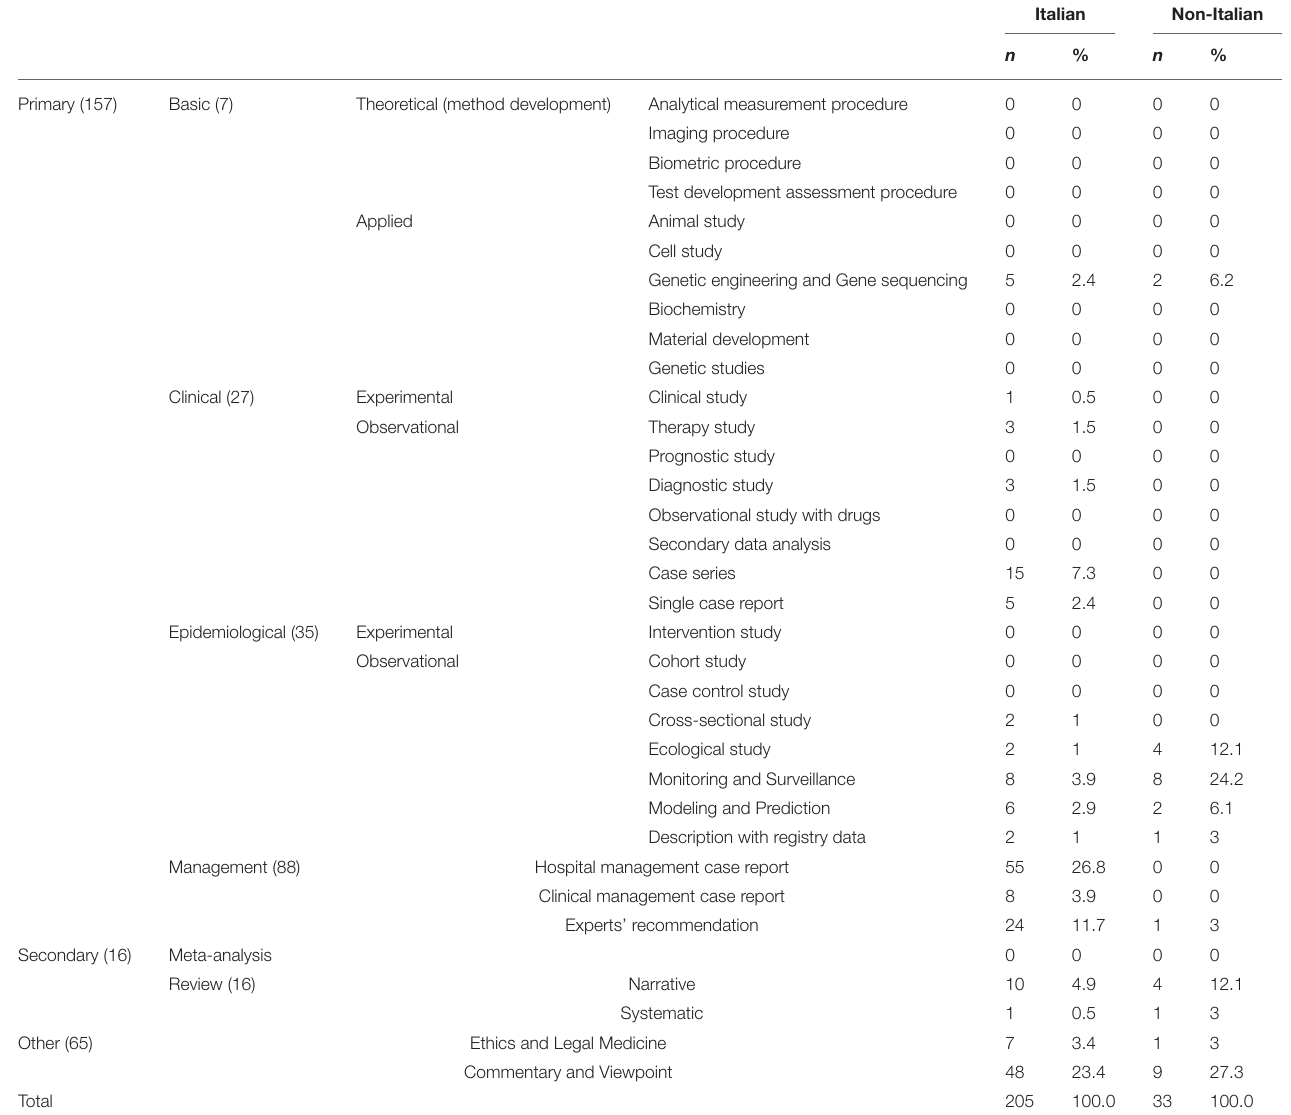
TABLE 1 | Classification of the 238 retrieved articles by type of